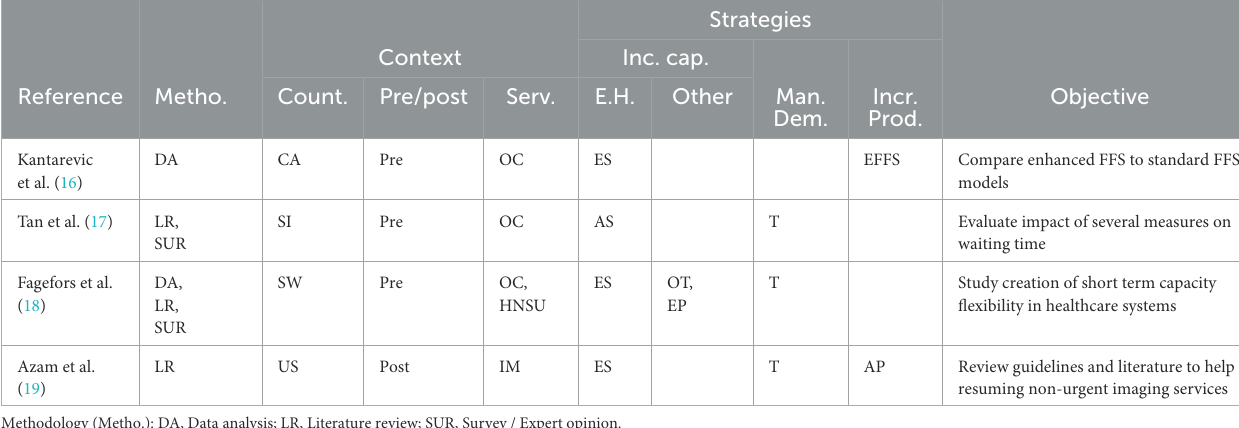
TABLE 1 Resulting papers concerning extended hours in non-surgical